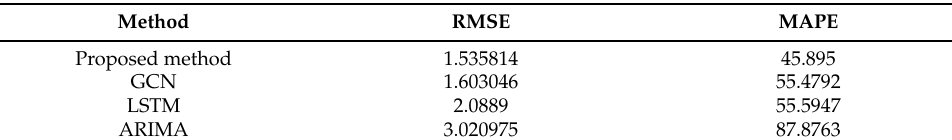
Table 4. Performance comparison.